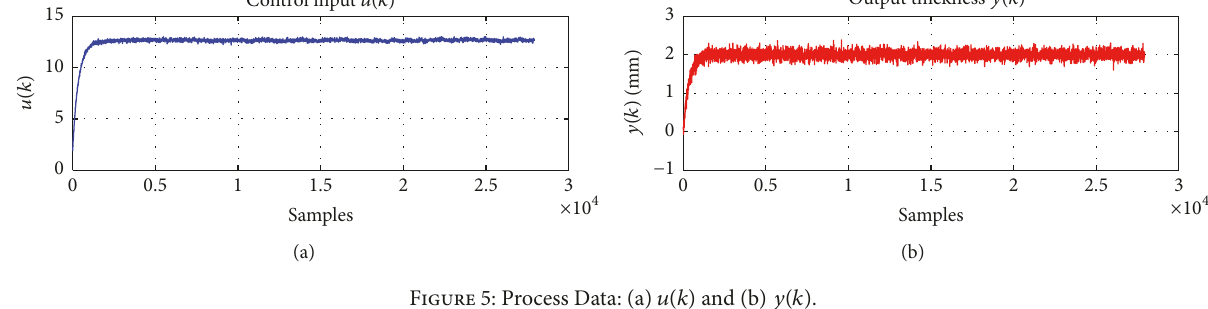
Figure 5: Process Data: (a) 𝑢(𝑘) and (b) 𝑦(𝑘) .